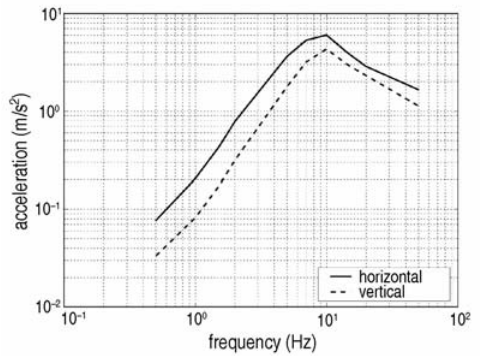
Fig. 11. Free field ground response spectra of INPP area, 2 % damping